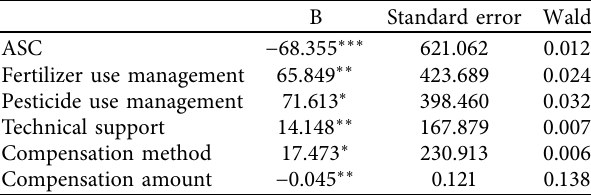
Table 7: Estimated results of the MNL